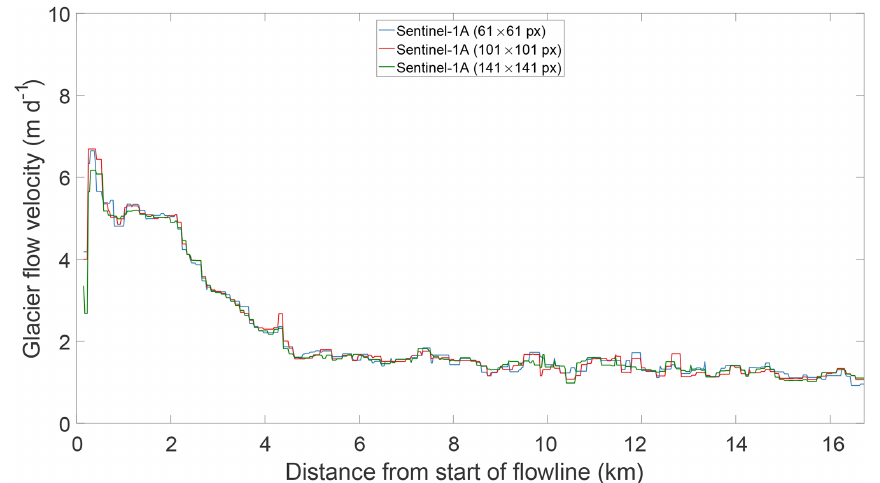
Figure 10. Mean flow velocity along the central flowline (see Fig. 1) between 8 July and 20 September 2016 for different template sizes. Smaller templates are better in capturing the velocity gradients occurring towards the glacier front, resulting in slightly higher flow velocities. Furthermore, the area affected by overlaps with surrounding areas of the glacier is diminished, resulting in reliable values closer to the glacier front. Bigger template sizes tend to result in smoother results.